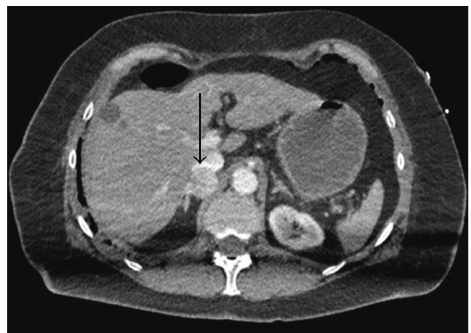
Figure 1: CT abdomen revealing a 22 mm nodule arising from the body of the right adrenal gland